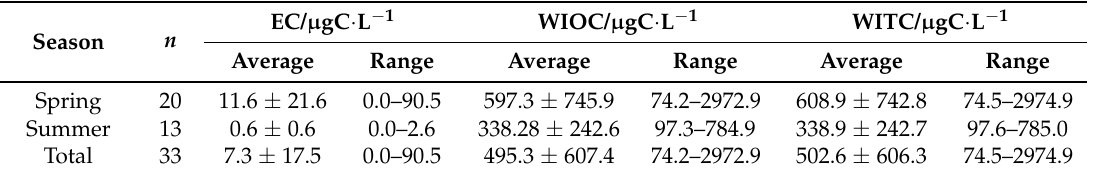
Table 1. Seasonal average and range of EC, WIOC and WITC in precipitation at Xiamen Island in